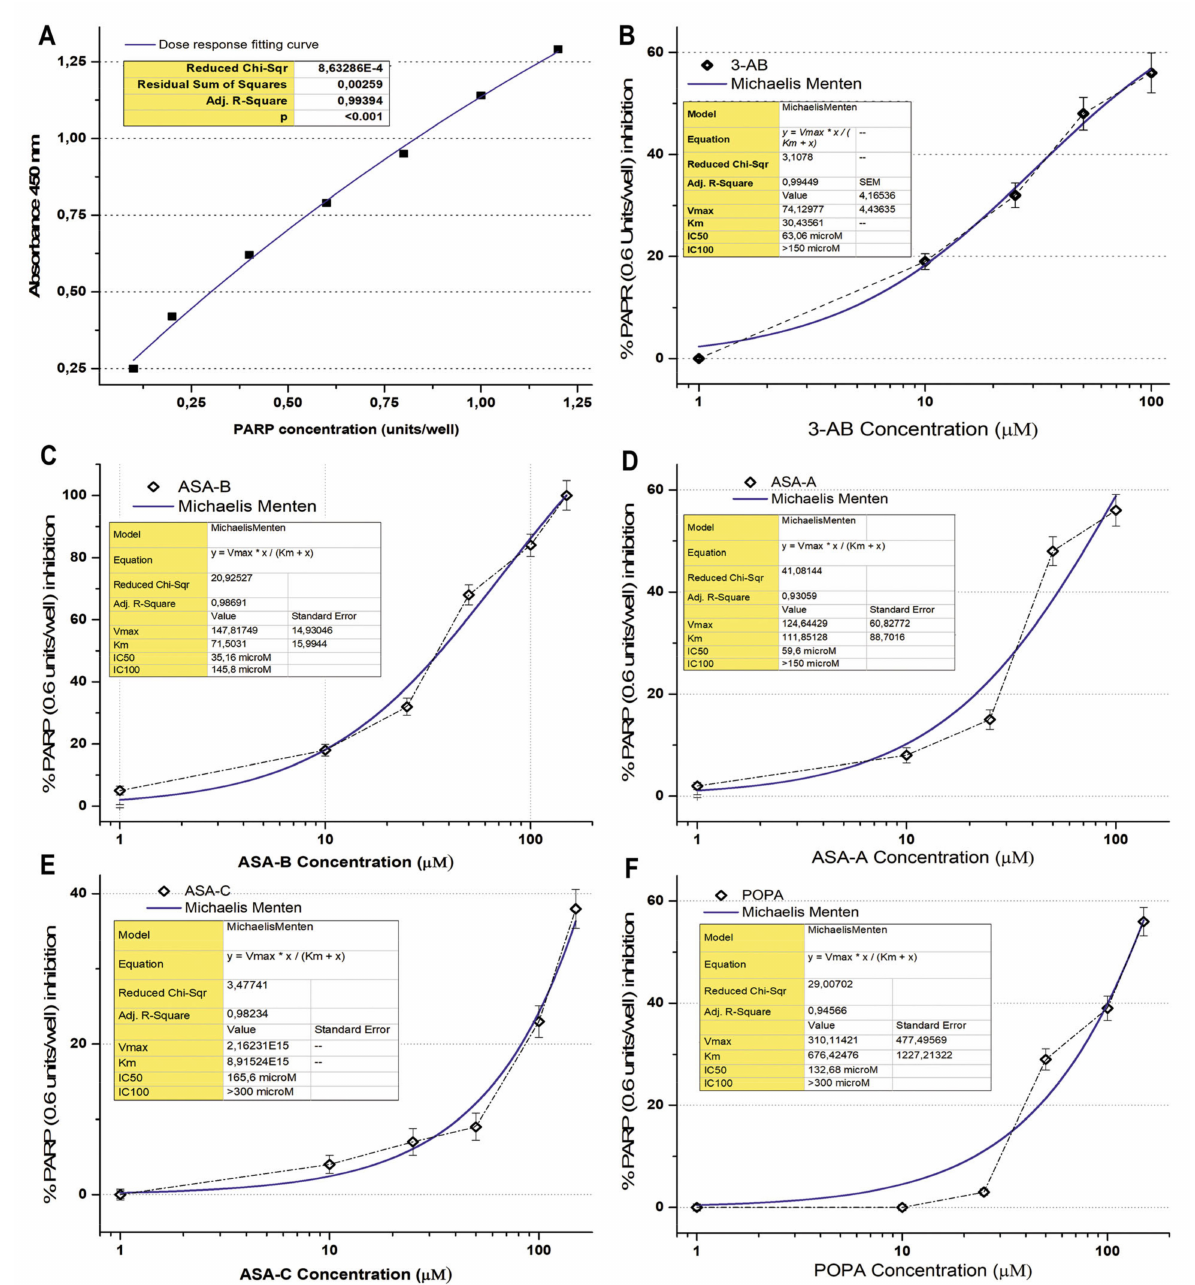
Figure 2. ( A ) Graphical representation of the colorimetric readout of the PARP dose response standard curve (Adj. R- square 0.994, p < 0.001); ( B ) PARP (0.6 units/well) inhibition curve and respective kinetics data analysis according to Michaelis Menten’s model for 3-aminobenzamide (3-AB); ( C ) PARP (0.6 units/well) inhibition curve and respective kinetics data analysis according to Michaelis Menten’s model induced by the B,D-bilactam, dehydroepiandrosterone-derived, steroid alkylator ASA-B; ( D ) PARP (0.6 units/well) inhibition curve and respective kinetics data analysis according to Michaelis Menten’s model induced by the B-lactam, dehydroepiandrosterone-derived, steroid alkylator ASA-A; ( E ) PARP (0.6 units/well) inhibition curve and respective kinetics data analysis according to Michaelis Menten’s model induced by the B-lactam, cholesten-derived, steroid alkylator ASA-C; ( F ) PARP (0.6 units/well) inhibition curve and respective kinetics’ data analysis according to Michaelis Menten’s model induced by the conjugant alkylator